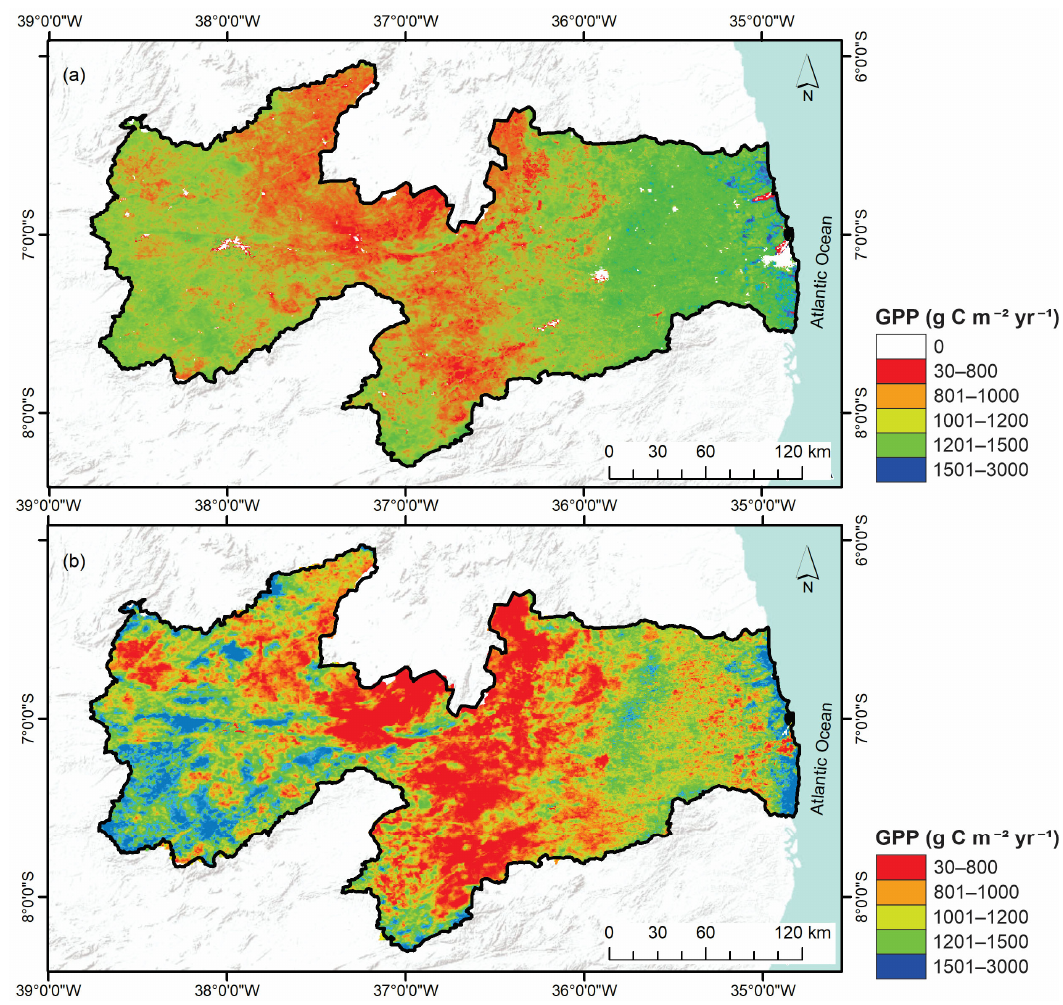
Figure 5. Annual GPP derived from the product MOD16A2 ( a ) and Modeled ( b ) for the state of Paraíba for 2013.